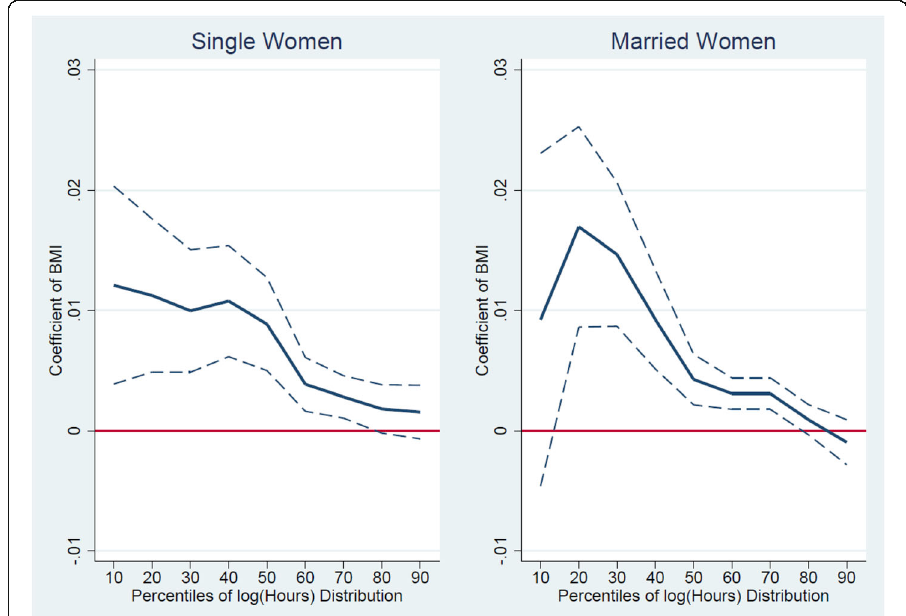
Fig. 2 BMI and log hours of work for White women: unconditional quantile regression estimates (with 95% confidence interval). Note: Control variables include work experience (quadratic), educational categories, dummies for whether the woman believes in traditional gender roles, whether the respondent has any children, if